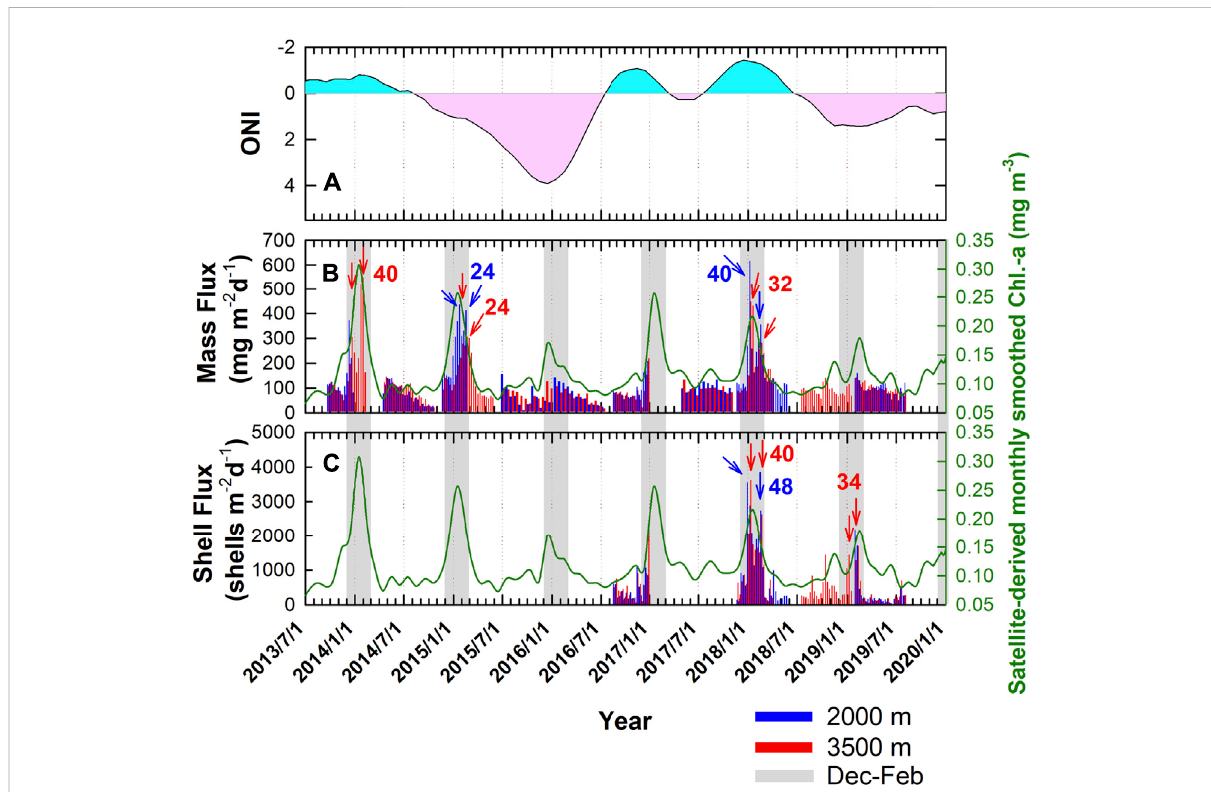
FIGURE 2 Timeseries of (A) ONI(pinkand lightblueareasrefertopositive andnegativevalues,respectively), (B) mass,and (C) totalshell fl uxes at2,000 m (blue) and 3,500 m (red), and (B and C) monthly average chlorophyll a concentration (green line) at SEATS. Gray bars indicate the periods of December to February. Blue and red arrows indicated the peak values at 2,000 m and 3,500 m depths, respectively. Numbers indicated the time intervals between the arrows (unit: